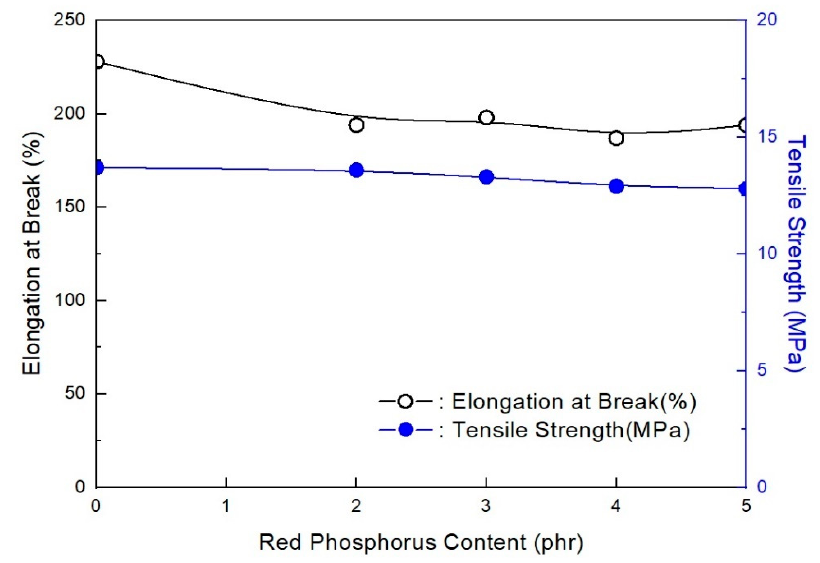
Figure 3. Mechanical properties of EVA/EXACT 8201/CLNA-8400/EBM/120 phr flame-retardant (MH+ZB) formulations as a function of additional RP content.